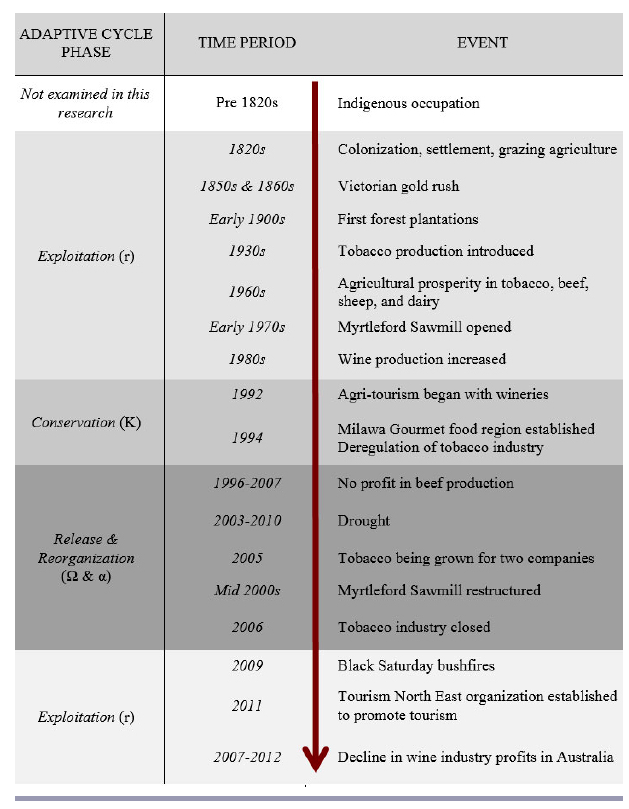
Fig. 7 . Timeline of key change events in the Ovens SES from European settlement (1820s) to present. The key change events are organized into the phases of the adaptive cycle that our analysis suggests that they occurred in. SES indicates social- ecological